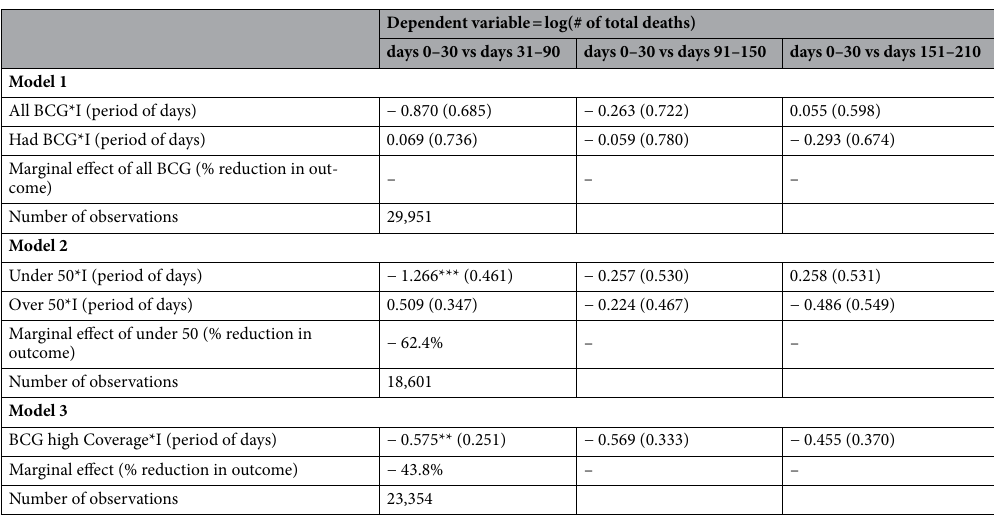
Table 1. Summary of effects of BCG in all three regression models: number of deaths on days 31–90, days 91–150 and days 151–210 compared with days 0–30. ***p < 0.01, **p < 0.05. Standard errors are clustered at country level. We calculate the marginal effects for the significant regression coefficients. In model 2, we convert the regression coefficients into marginal effects by exp( α k × mean of Under 50 i ) − 1. In model 3, we convert the regression coefficients into marginal effects by exp( α k ) −